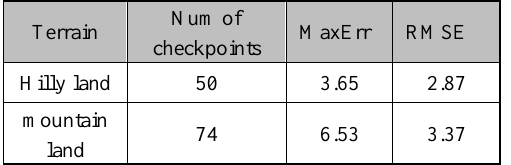
Table 18 statistics of plane geometric accuracy of Orthophoto (unit: